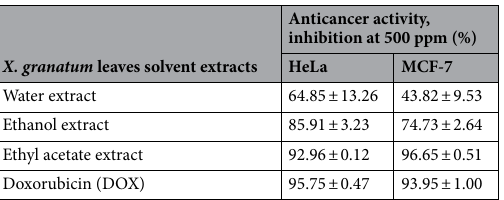
Table 1. X. granatum leaves extracted with different solvents against HeLa and MCF-7.